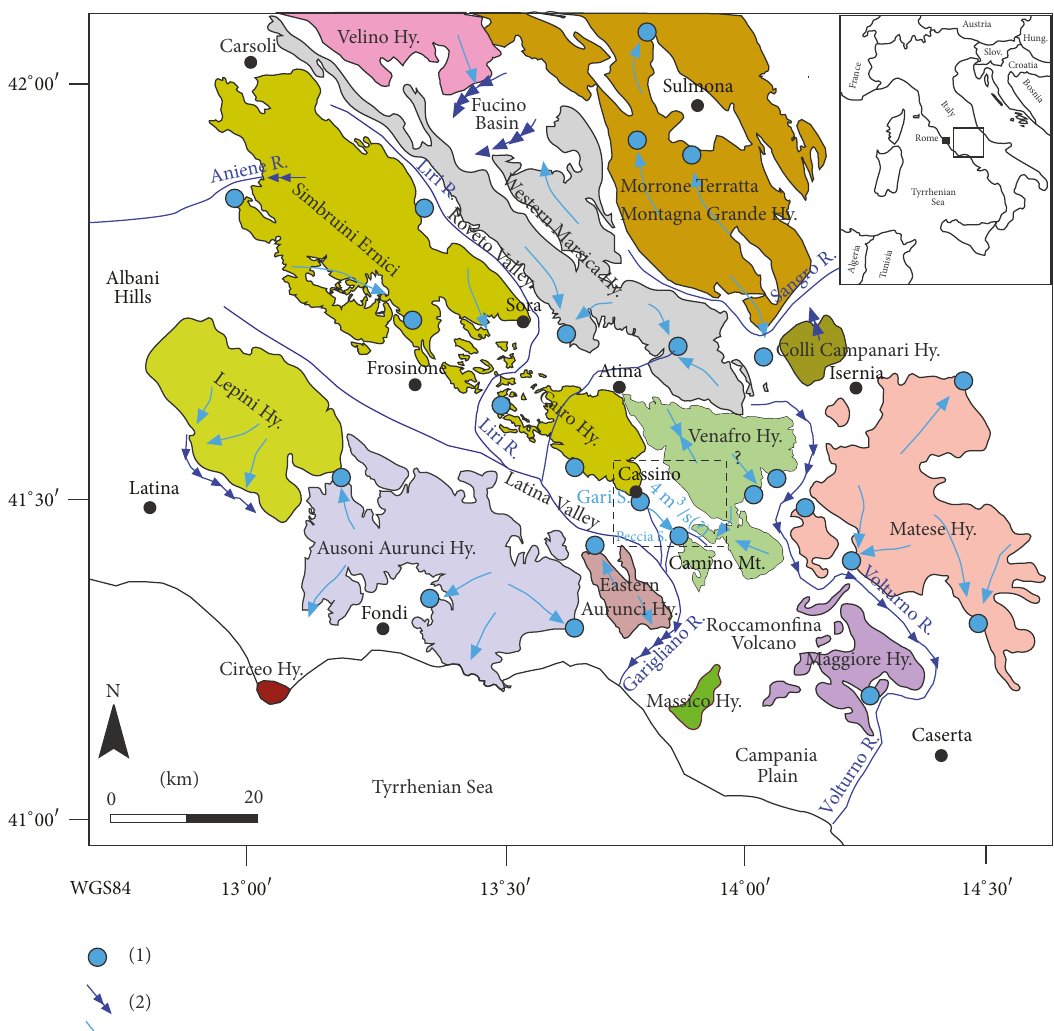
Figure 1: Mesozoic to Cenozoic karst hydrostructures surrounding the study area (black rectangle). Different colours indicate the limit of the different hydrogeological basins. White areas indicate Miocene to Quaternary sedimentary to volcanic aquitards and aquicludes. In literature, the independence of the Venafro hydrostructure is debated [4, 23–25, 42]. Key to the legend: (1) karst springs; (2) karst streambed